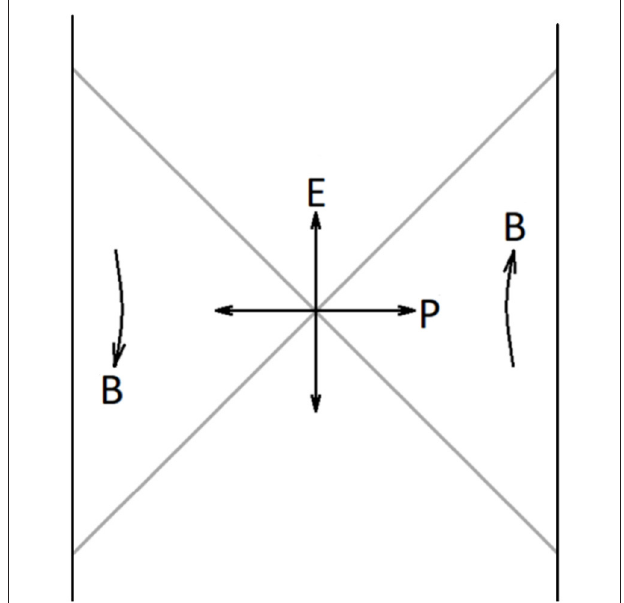
FIGURE 7 | Penrose diagram for a two-sided non-dynamical background in the limit of low temperature and infinite throat length. Also shown are the matter generators E , B , P that generate SL (2, R ) motions of the matter fields. The generators have been normalized so that the commutation relations are [ B , E ] = iP , [ B , P ] = iE , [ P , E ] = i J 2 B